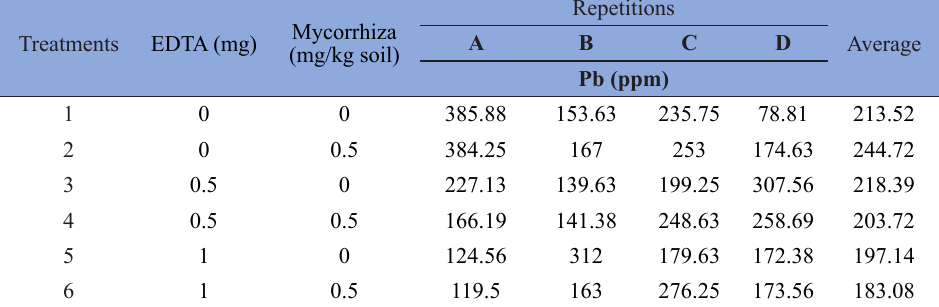
Similarly, Figure 3 shows that as in the case with plant heights, treatments 1 and 2 produced the longest roots while treatments 3 and 4 produced the shortest roots. However, for the same concentration of EDTA, the longest roots occurred in the presence of mycorrhizae.